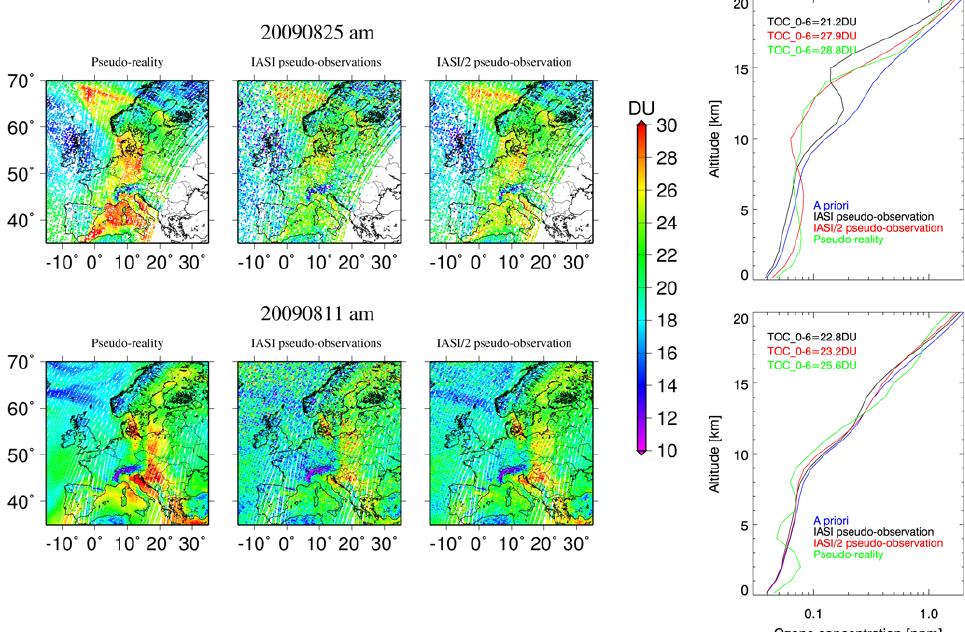
Fig. 13. Maps of raw MOCAGE pseudo-reality, and IASI and IASI/2 pseudo-observations for the days 25 (top) and 11 August 2009 (bottom), AM overpass. Vertical ozone concentration profiles from a priori (blue), MOCAGE pseudo-reality (green), and IASI (black) and IASI/2 pseudo-observations (red) over Berlin for the two days are also